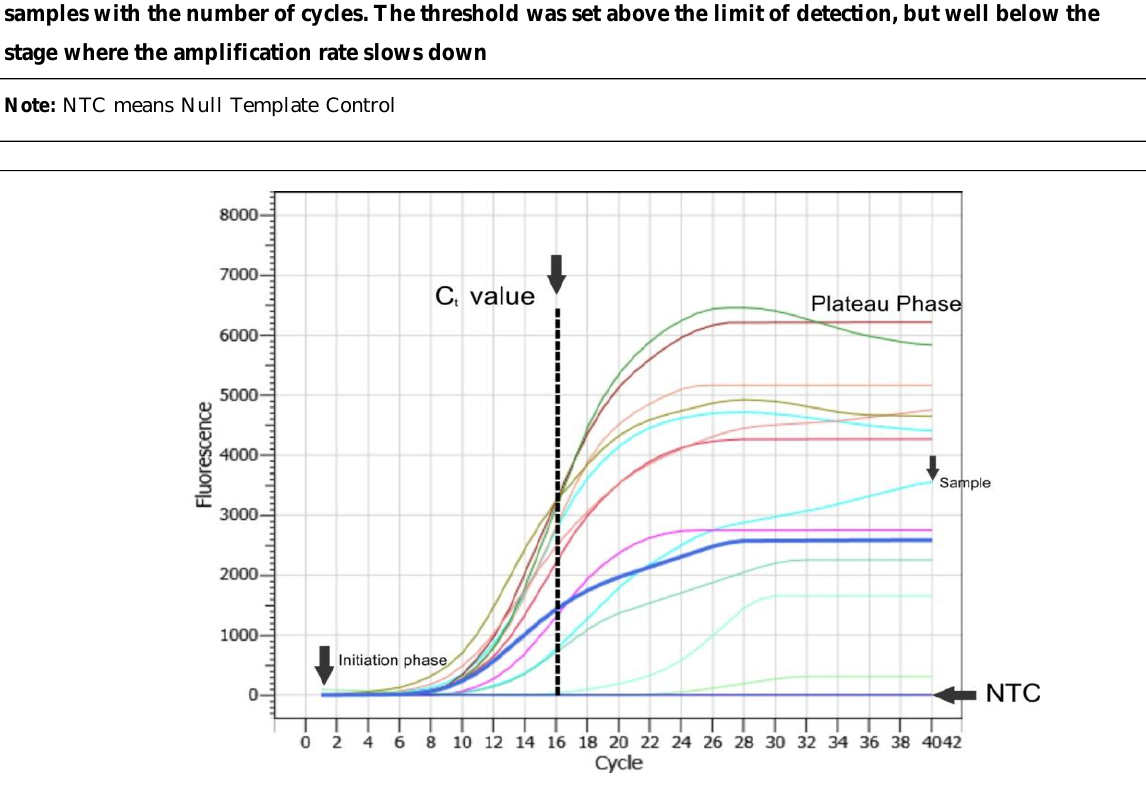
Figure 2: Amplification curves for LmcesE9. This graph shows the increase of fluorescence with the number of cycles for different samples. The threshold was set above the detection limit but well below the plateau phase where the amplification rate slows down Note: NTC means Null Template